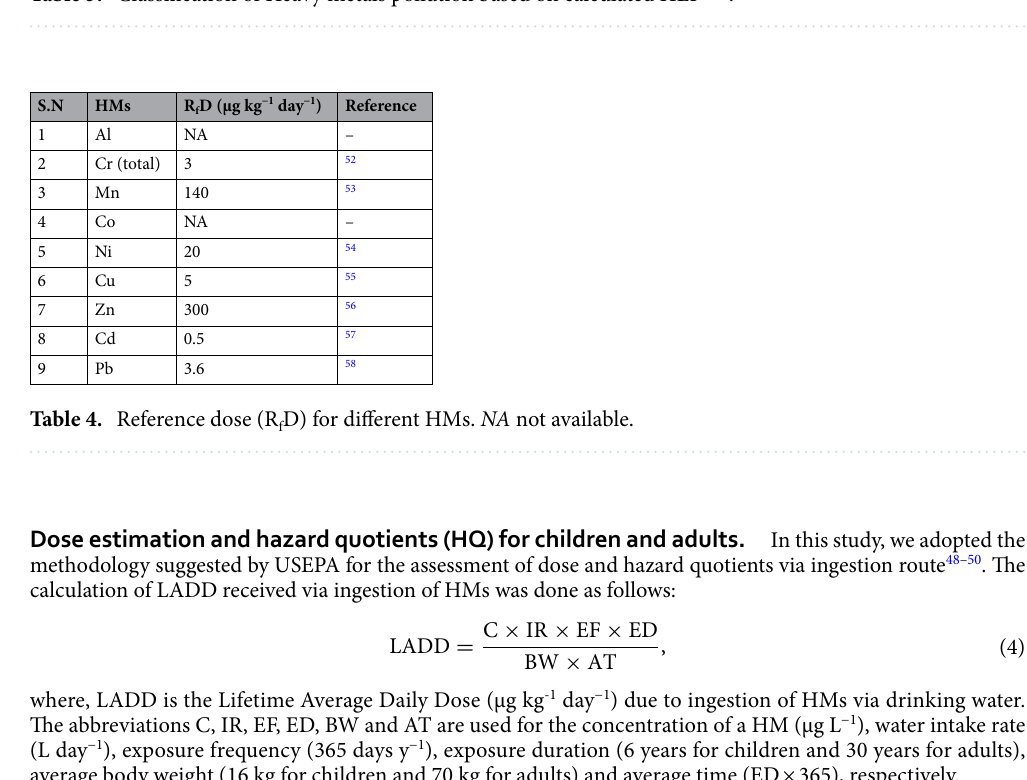
Table 3. Classification of Heavy metals pollution based on calculated HEI 39,44 .